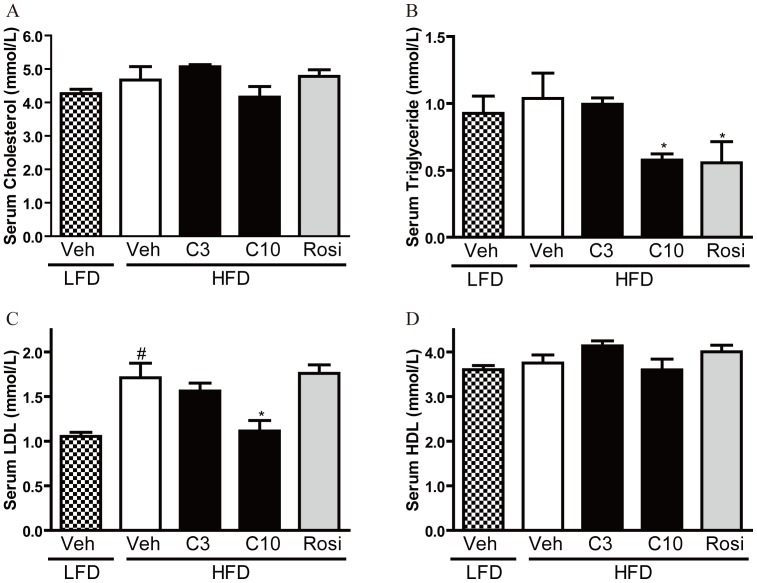
CMHX008 protects HFD induced dyslipidaemia.C57BL/6 mice were fed with HFD or LFD for 16 weeks. Then HFD fed C57BL/6 mice were treated with CMHX008 (3 and 10 mg/kg, HFD-C3 and HFD-C10), rosiglitazone (3 mg/kg, HFD-Rosi) or vehicle (HFD-Veh or LFD-Veh) only, for additional 5 weeks. Trunk blood was collected at the end of the experiment. Serum was used for the measurement of cholesterol (A), triglyceride (B), low-density lipoproteins (LDL, C) and high-density lipoproteins (HDL, D). Data are the means ± S.E.M., n = 4–5; #
P<0.05 vs LFD-Veh and *P<0.05 vs HFD-Veh.